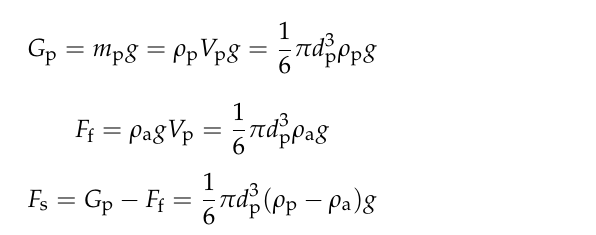
G and air buoyancy p